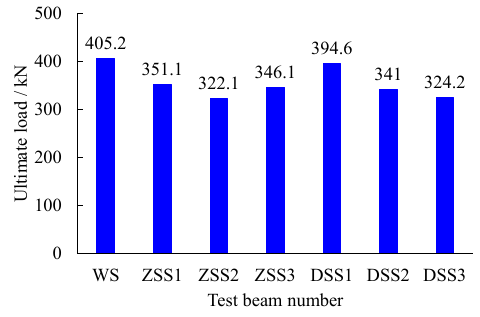
Figure 12. Ultimate load of test beam.